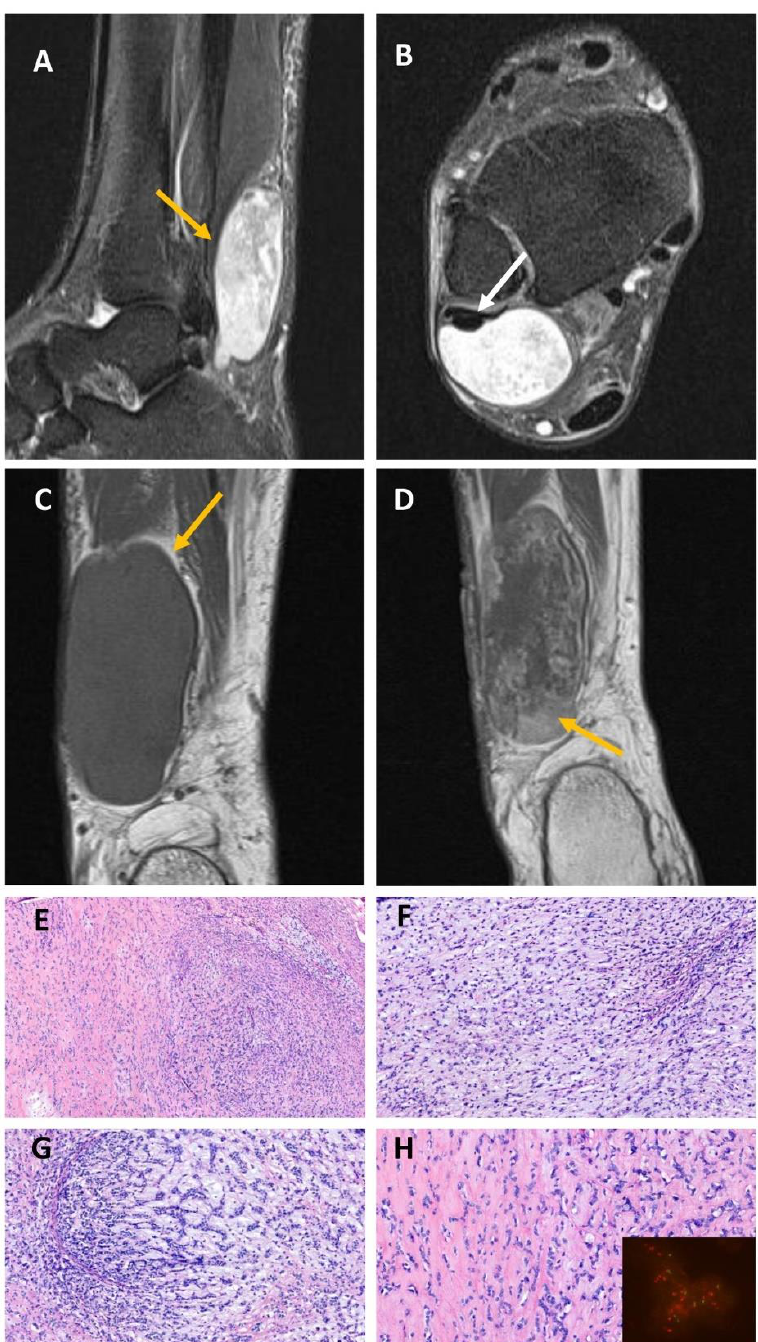
Figure 6. Soft tissue tumor of the distal lower leg in a 69-year-old patient with a EWSR1::NFATC2 fusion (case #4). ( A – D ) MRI images show a well-demarcated lesion in the distal fibularis brevis muscle with a heterogeneous high signal on TIRM (turbo inversion recovery magnitude) images (( A ) — yellow arrow, ( B ) — white arrow) and homogenous intermediate signal in comparison to the surrounding muscle on T1-weighted image (( C ), yellow arrow). Heterogeneous contrast enhancement of the lesion (yellow arrow) is seen on the postcontrast-T1-weighted image ( D ). ( E – H ) Histologically, the tumor has hypo and hypercellular areas with a variable stroma component — fibrous, myxoid, and myxohyaline. The monomorphic ovoid to epithelioid tumor cells are arranged in interconnecting cords, strands, or nests. ( H ) FISH with EWSR1 probe shows EWSR1 amplification (inset).